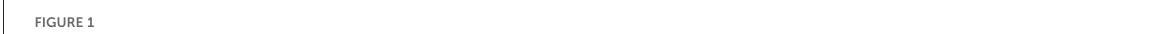
FIGURE1 the 69 sections depicted in the atlas. The intercommisural line (ICL) and the vertical line (VCA) pass through the center of the anterior and posterior commissure, and the center of the anterior commissure, respectively. (B) Pig brain. Coronal and sagittal sections in this example show the coordinates 14.50mm ahead of the posterior commissure and 4.00mm laterally from the midsagittal plane, respectively. (C) Cat brain. Coronal and sagittal sections are examples of Nissl stained sections from the adult cat (Felis Catus). (D) Dog brain. Coronal and sagittal sections are shown in the maps of the whole brain from a 5 month old dog (Canis Lupus). The blue line shows the levels at the frontal lobe Images in (A) are reproduced from the human brain website https://www.thehumanbrain.info/brain/sections.php. Retrieved May 12, 2022. Images in (B) are reproduced from the Stereotaxic atlas of the pig brain by Felix et al. (1) with permission from Elsevier. Images (C,D) are reproduced from the brain maps website http://brainmaps.org/ajax-viewer.phpdatid=32&sname=p099-100, retrieved on May 13,